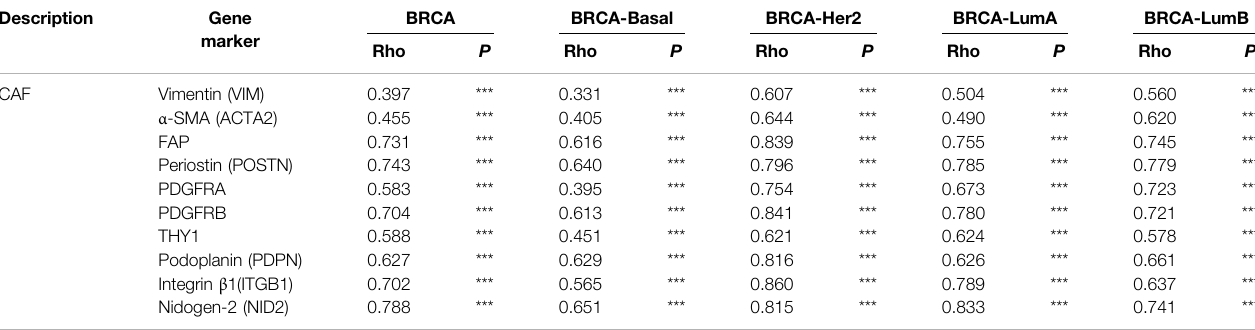
BRCA, breast invasive carcinoma; CAF, cancer-associated fi broblast; Purity, correlation adjusted for tumor purity; Cor, R value of Spearman ’ s correlation. * p < 0.01; ** p < 0.001; *** p < 0.0001.